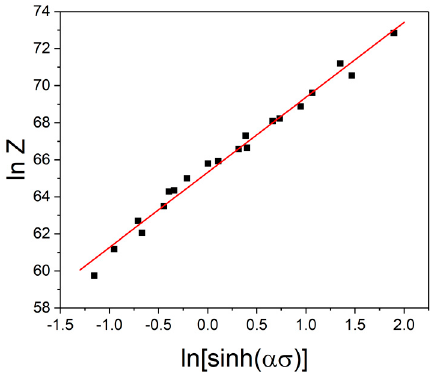
Figure 6. Relationship of the PM/Wrought dual superalloy between lnZ and ln[sinh( α )] σ .